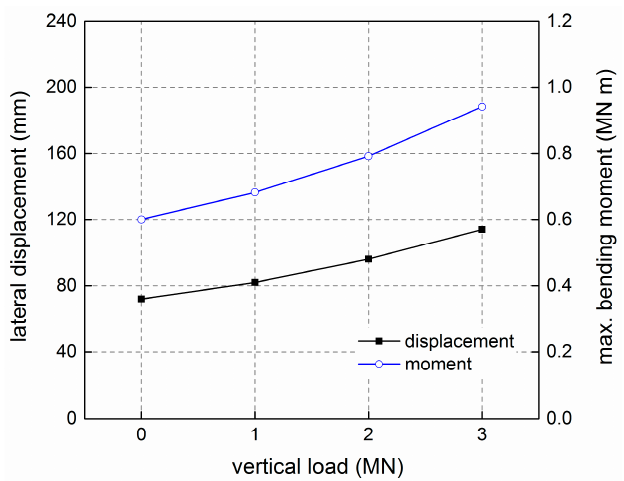
Figure 1. Influence of vertical loading on the lateral displacement and maximum bending moment of a laterally-loaded pile [13] .